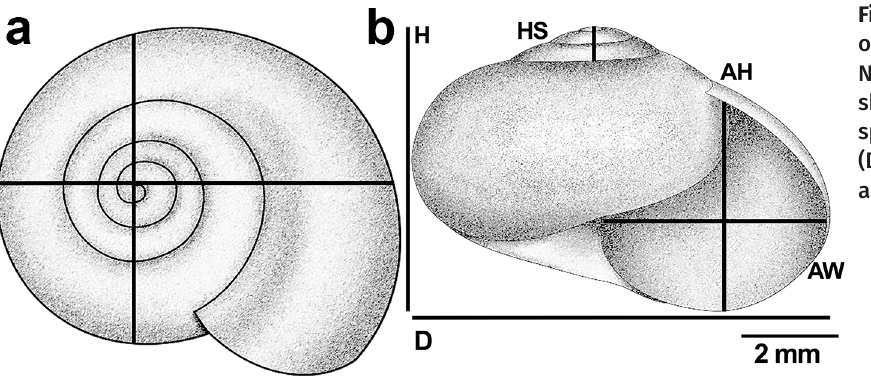
Figure 1. Shell measurements of Ovachlamys fulgens. a . Number of whorls of the shell; b . Shell height (H), spire height (HS), shell width (D), aperture height (AH), aperture width